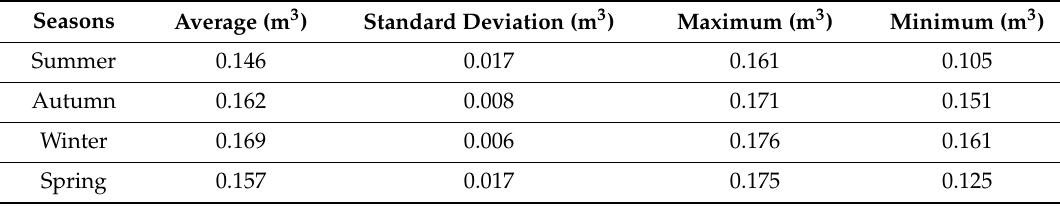
Figure 7. Average water consumption per capita separated by season (it does not include water consumption in toilets). Table 3. Standard deviation, maximum and minimum water consumption per capita, including all water consumption data, separated by season of the year (it does not include water consumption in toilets).